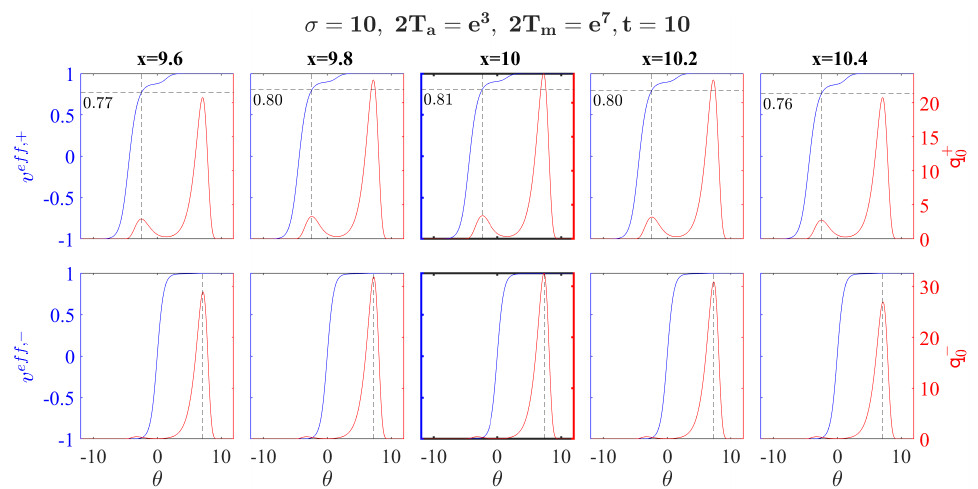
Figure 5: Effective velocities (left axis, red) and spectral density cross-sections (right axis, blue) of particle ( ` ) in row 1 and ( ´ ) in row 2 at time t “ 10 in the case of “ e 3 . For particle ( ` ) we see the subsidiary (persisting) and bath temperature 2 T a free fermion peaks whereas for particle ( ´ ) we see the (large) interacting peak a very small bump corresponding to the bath (for particle ( ` ) this is masked by the persisting peak sitting right on top). Columns show these quantities sequentially for positions x “ 9.6,9.8,10,10.2,10.4. The emphasised central column corresponds to x “ x ˚ “ 10 the position of the maximum of subsidiary peak of particle ( ` ). The vertical dashed lines indicate the maximum of particle ( ` ) subsidiary peak ( θ ˚ “ ´ 2.39) in row 1 and the maximum of particle ( ´ ) interacting peak in row 2, which is around the value θ ˚ ` σ as dictated by the structure of the scattering phases. The horizontal dashed lines indicate the effective velocity of the maximum of particle ( ` ) subsidiary peak and are annotated with the corresponding numerical